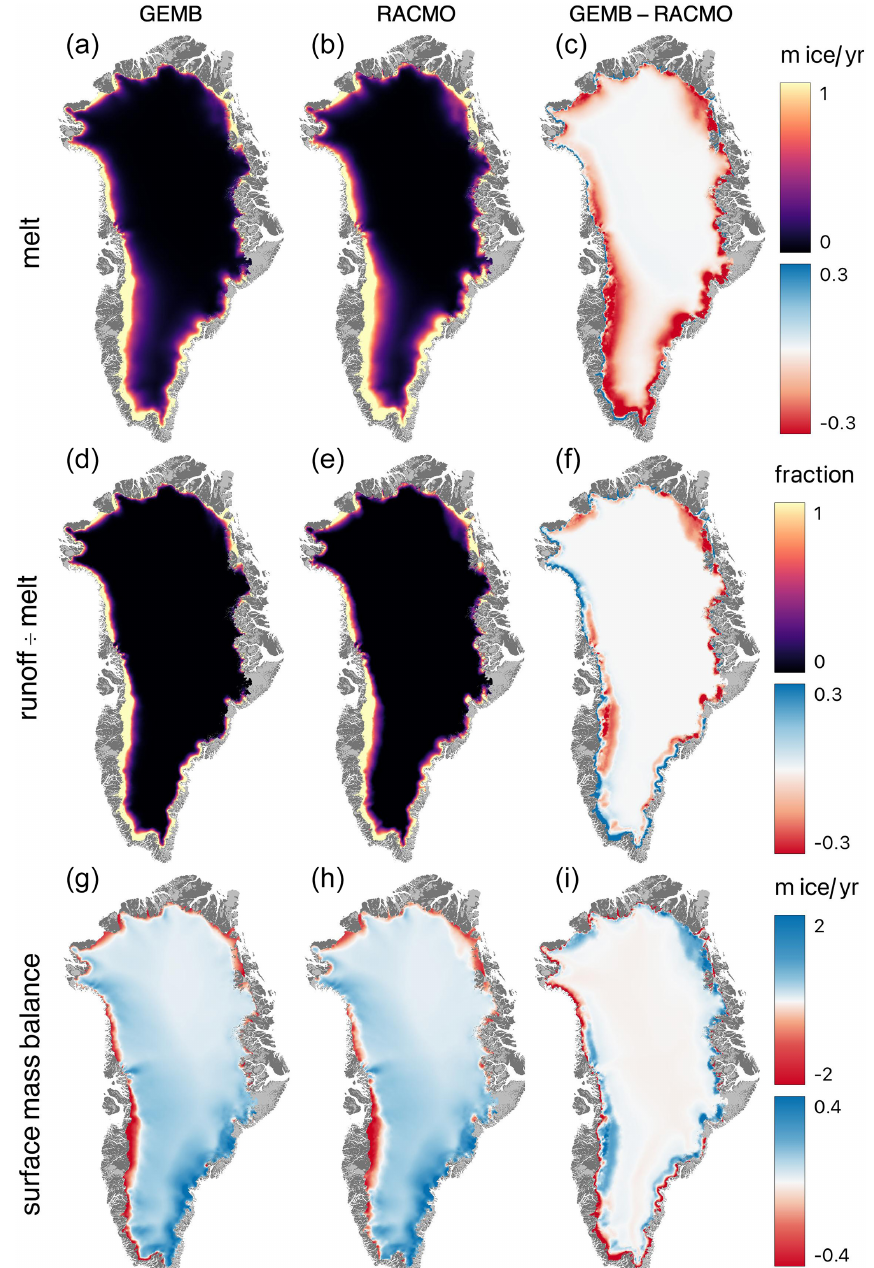
Figure 5. Mean 1979–2014 Greenland Ice Sheet GEMB (a, d, g) and RACMO (b, e, h) model output in meters of ice equivalent and their difference (c, f, i)